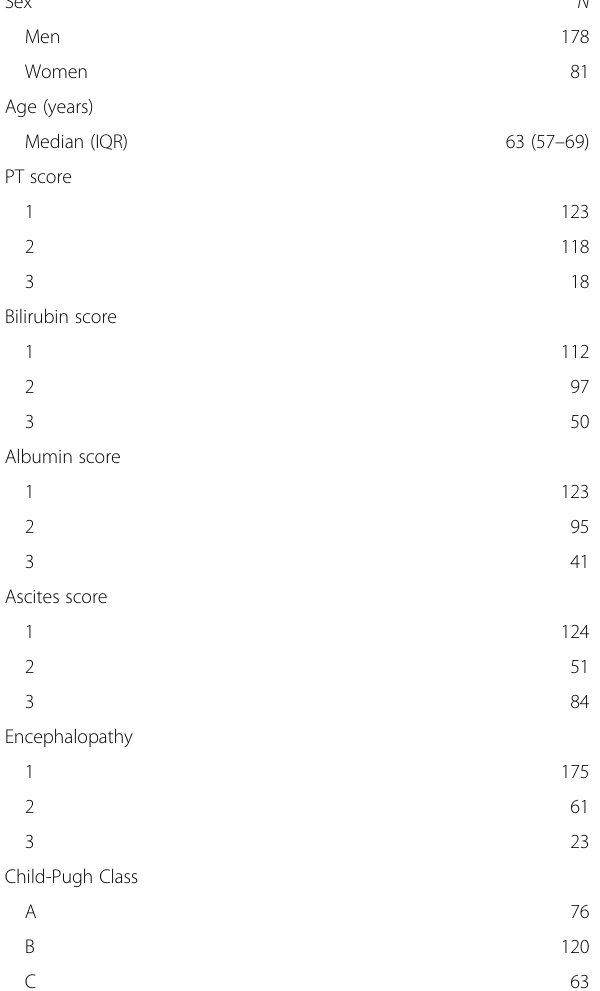
Table 3 Demographic, clinical, and laboratory characteristics